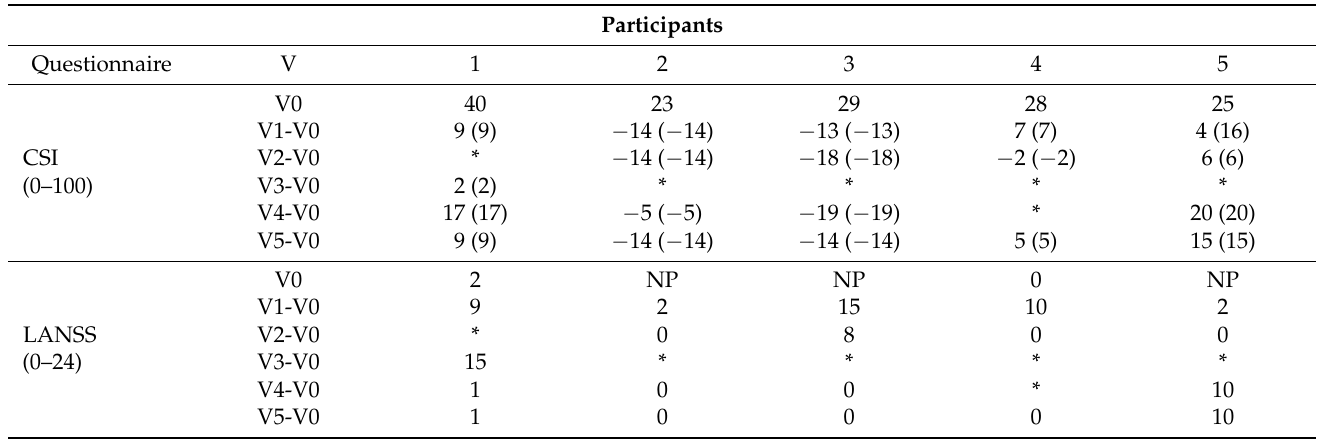
Table 5. Changes (percentage) in self-reported measurements